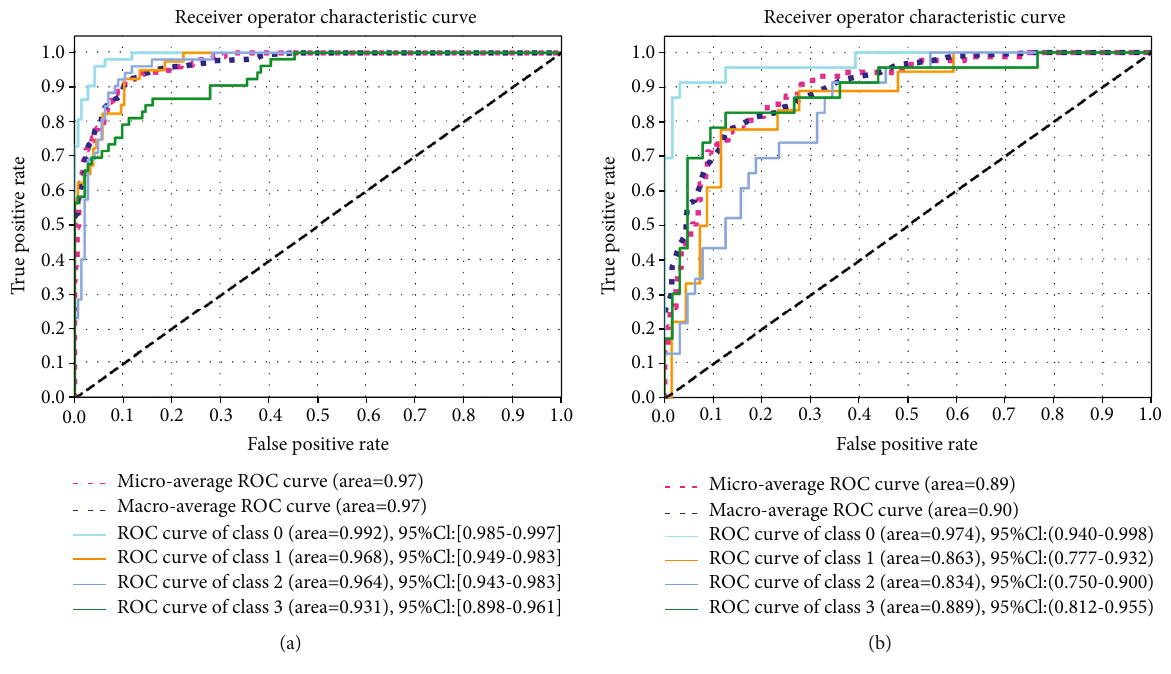
Figure 7: ROC curves of the SVM classi fi er on the training set (a) and test set